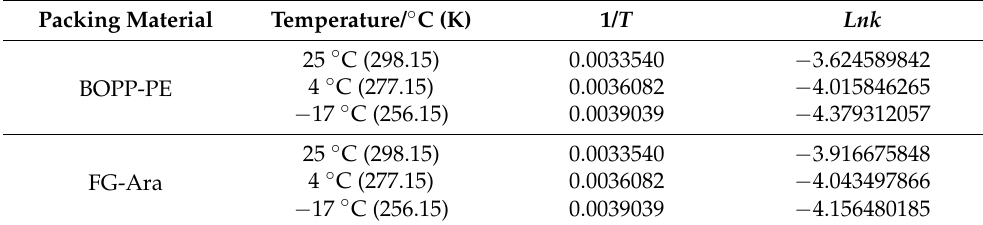
Table 7. Corresponding relationship between temperature and oxidation rate of soybean oil encap- sulated by biaxially oriented polypropylene-polyethene (BOPP-PE) film and fish skin gelatin/L- arabinose (FG-Ara)